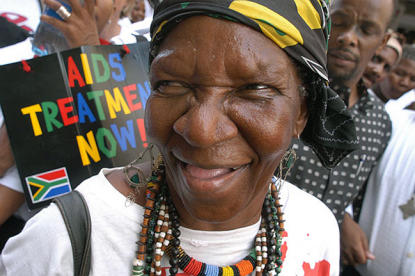
A rally to demand greater access to HIV medicines(Photo: Eric Miller)